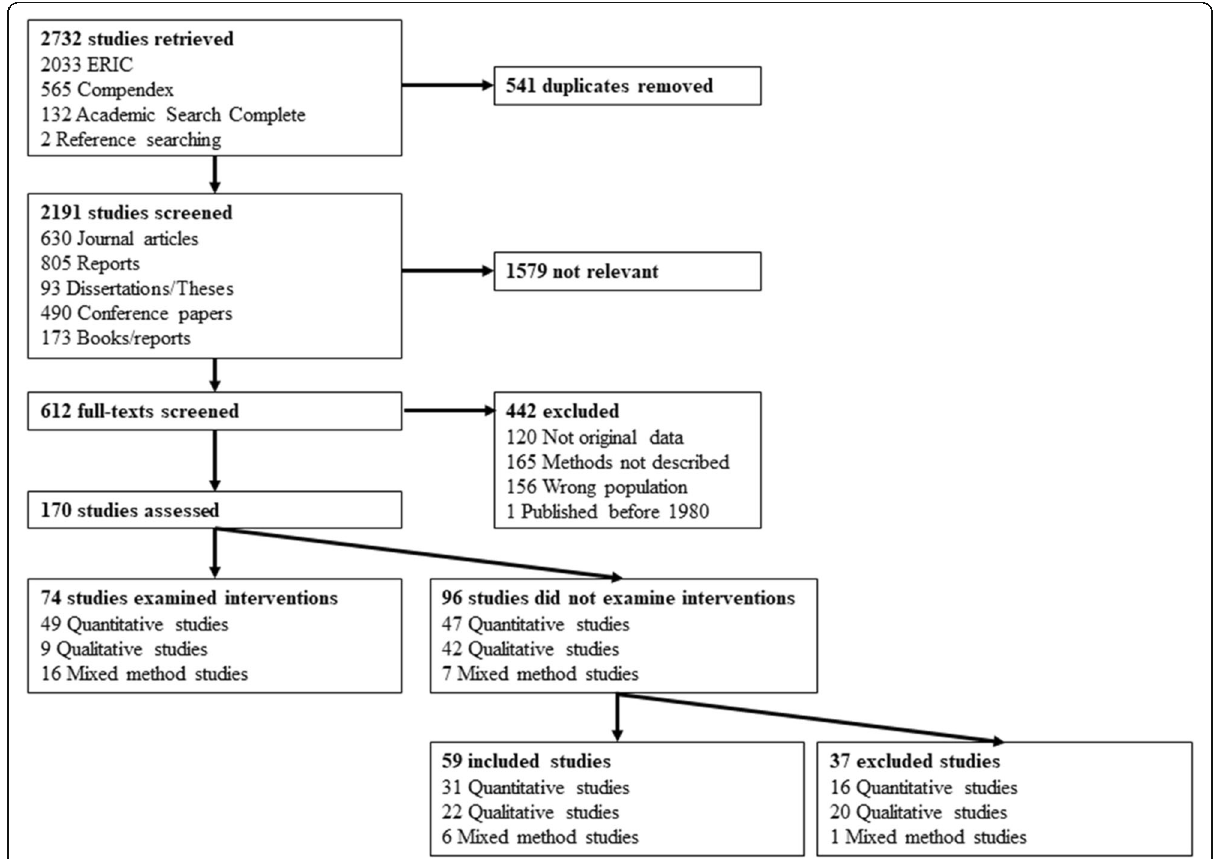
Fig. 1 Article screening process. This figure illustrates the flow and number of studies through the search, selection, and coding